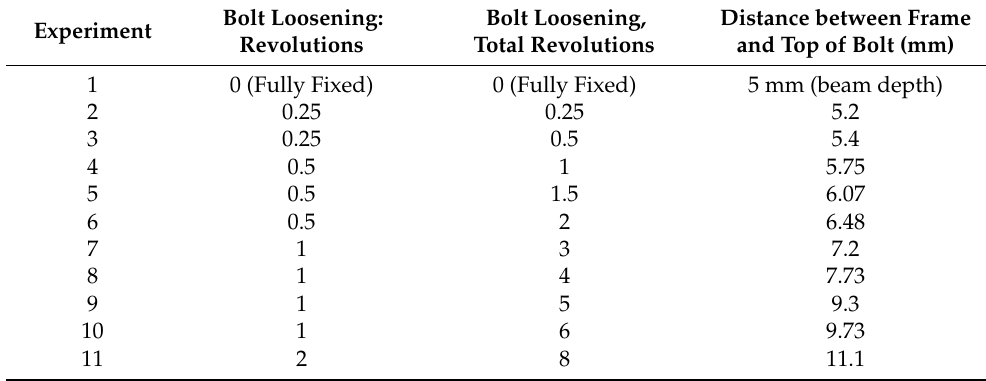
Table A1. Experimental bolt-loosening progression experiment (discrete).